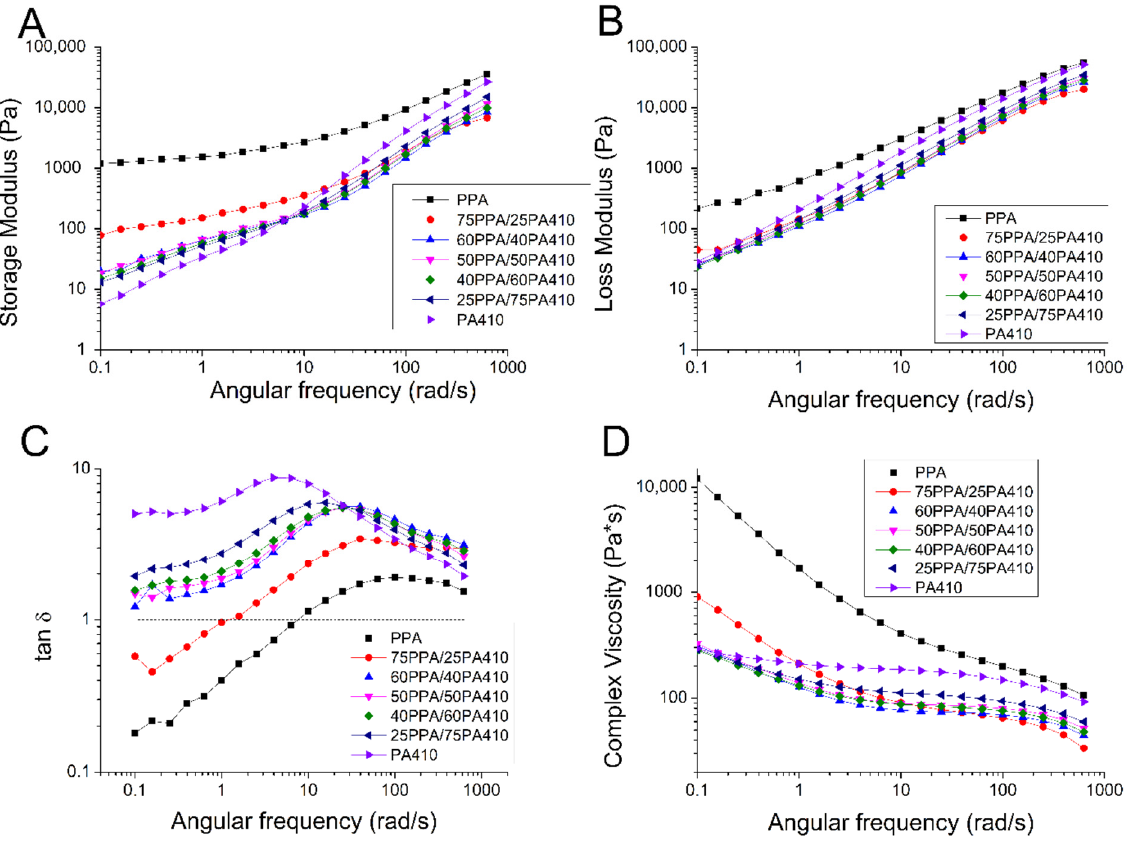
Figure 7. Dependence of rheological properties of the PPA, PA410 and their blends on angular frequency: ( A ) storage modulus; ( B ) loss modulus; ( C ) tan delta; and ( D ) complex viscosity.